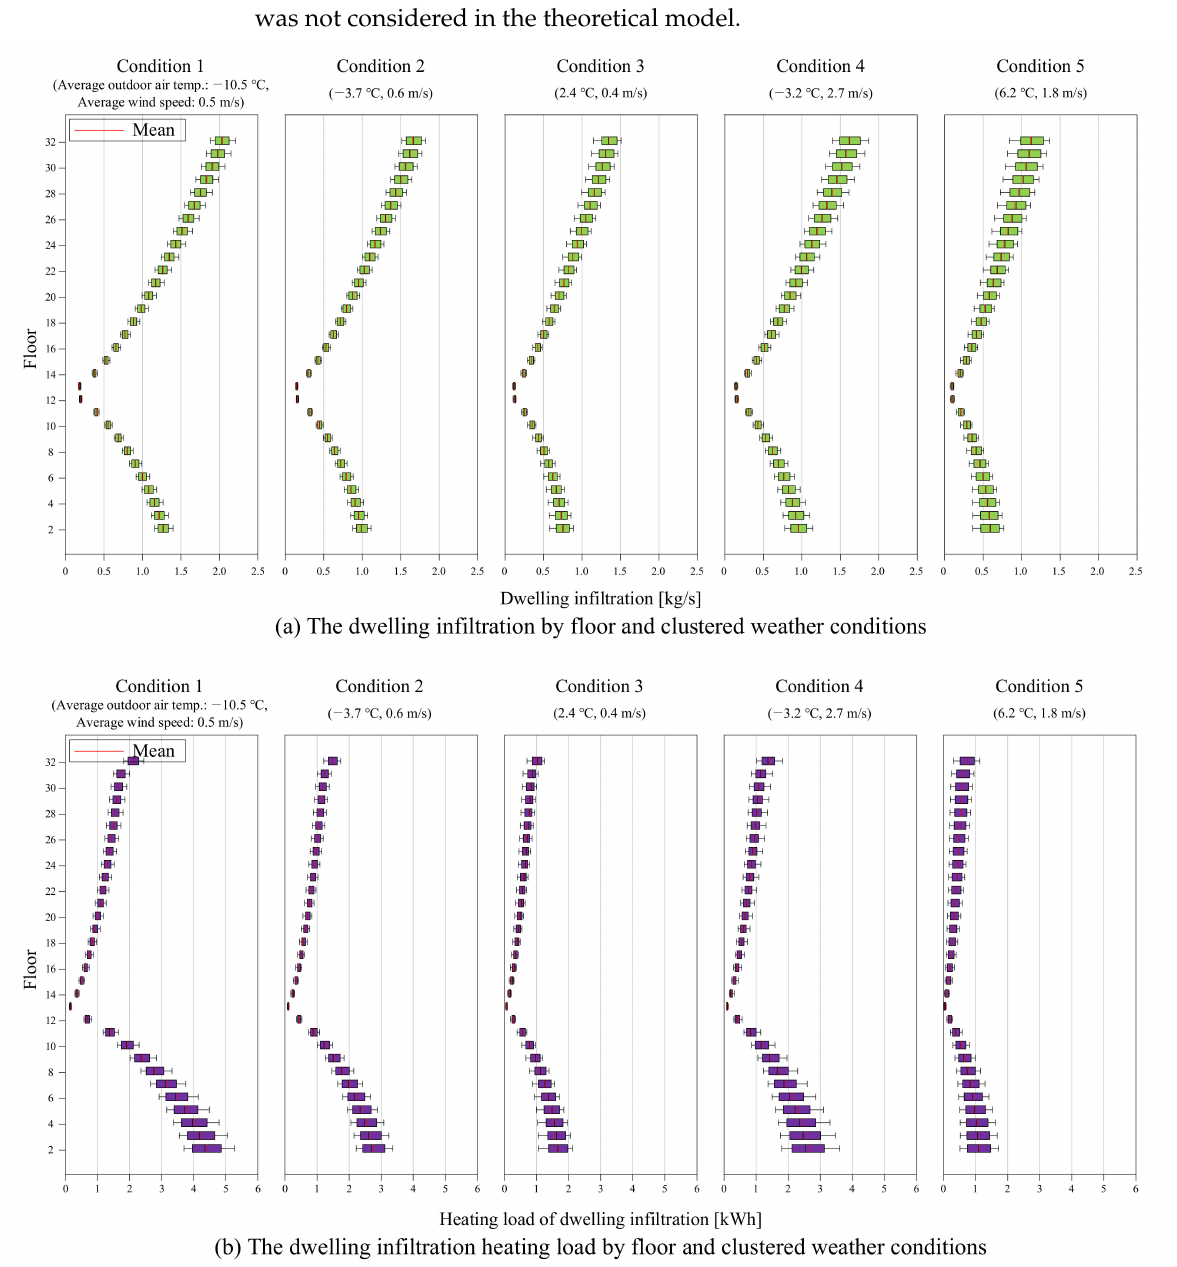
Figure 6. The dwelling infiltration and heating load by floor under the clustered weather conditions. As shown in Figure 6b, the heating load of the dwelling infiltration also increased with increasing distance from the NPL. The heating load under the NPL was larger because of the stack-driven outdoor air infiltration temperatures, although the outdoor air infiltration rates were lower than the interzonal airflow rates above the NPL. The heating loads above the NPL were smaller owing to the higher temperatures of the interzonal airflow from the corridors. Specifically, the increasing rate of heating load by the floor on the top floor (32F) was relatively high. This was because the interzonal air temperatures of the corridor were lower on the top than on the other floors owing to the heat transfer with the exterior roof. The stronger the stack effect, the greater the difference in the heating load between